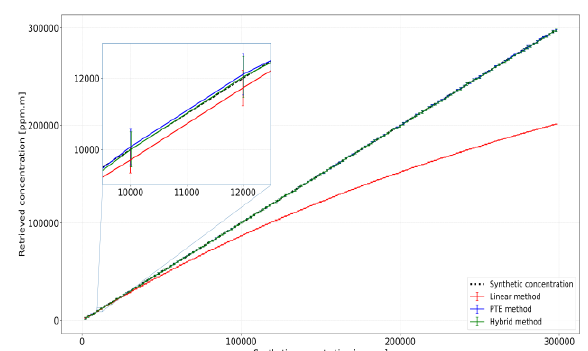
Figure 5 . Retrieved concentrations for the three methods according to the synthetic plume concentration in brick full- synthetic case. A zoom between 9500 and 12500 ppm.m is overplotted in the insert of this figure.